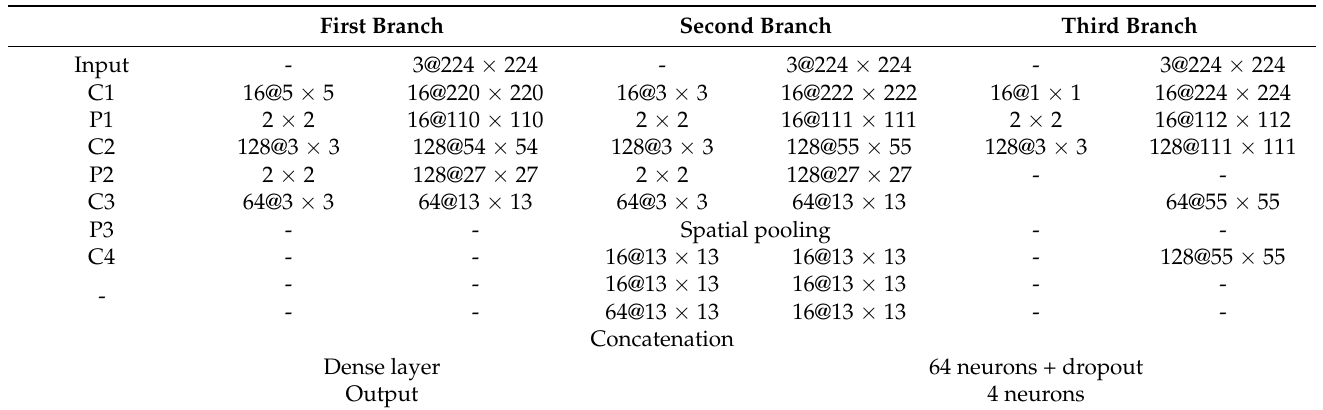
Table 1. Details of fused multi–scale feature convolutional neural